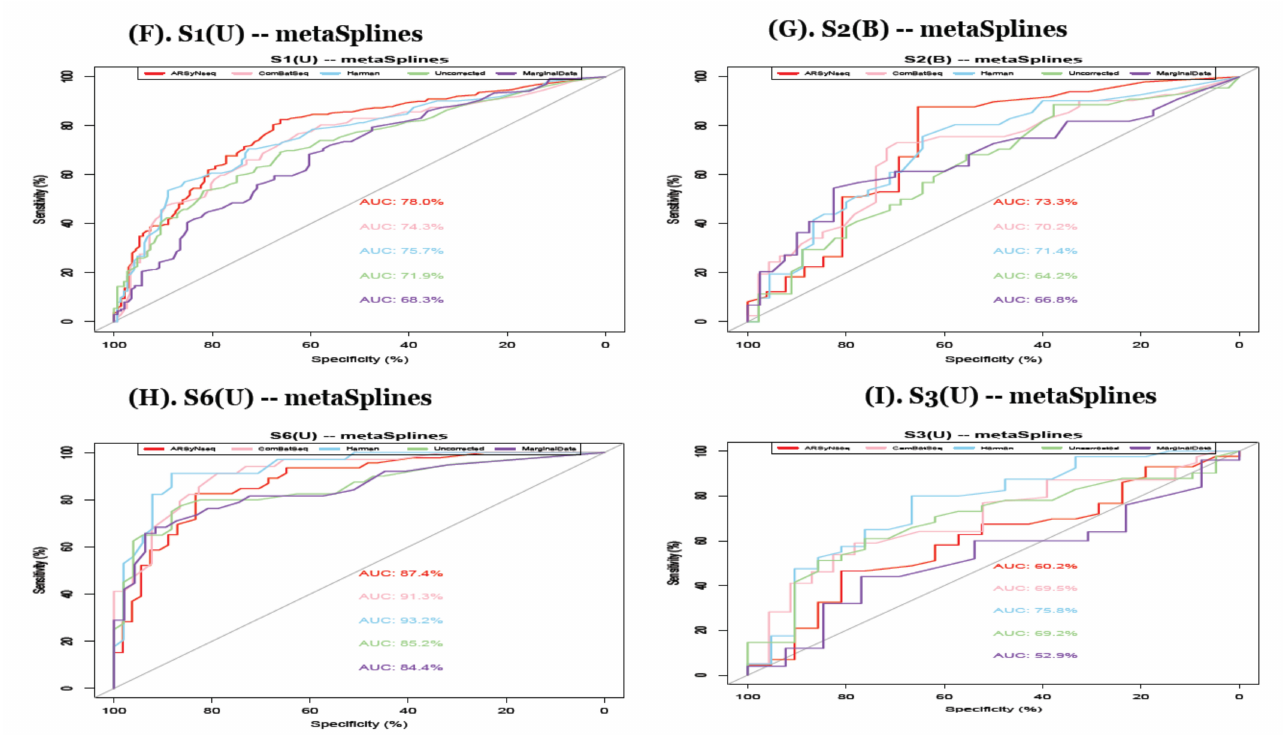
Figure 8. ( A – E ) show the ROC curves in simulation studies to confirm that Harman-corrected data show the best performance as shown in real data application. (S2B, S2U, S5B, S5U, and S6U for dream method in clockwise from top-left) dreamW represents the model including primer. Sets of the known batch factor as one of main factors and dream WO excludes it in the model. ( F – I ) show the ROC curves in simulation studies to confirm that Harman-corrected data show the best performance as shown in real data application. (S1U, S2B, S3U, and S6U for metaSplines method in clockwise from top-left) dreamW represents the model including primer. Sets of the known batch factor as one of the main factors and dream WO excludes it in the